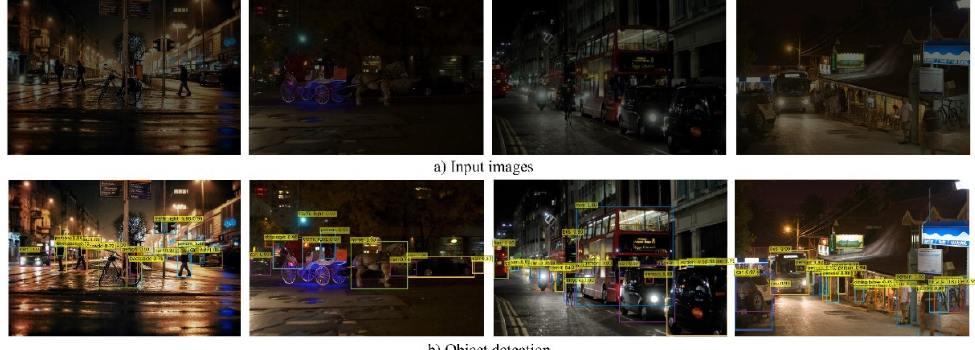
Figure 7. The results of the object detection and recognition model on the ExDark [69] dataset.